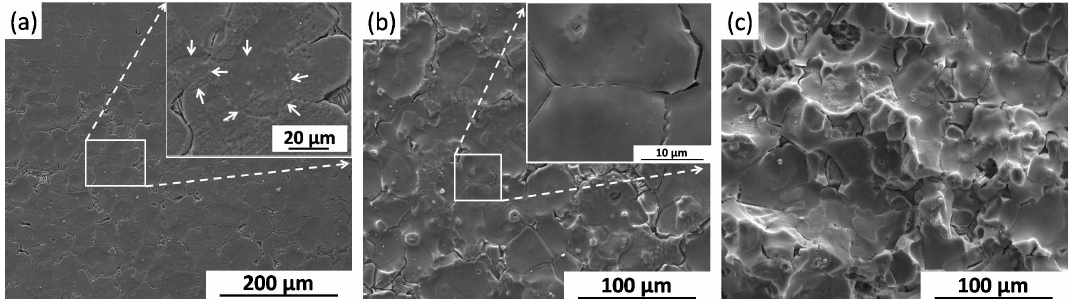
Figure 13. Surface morphologies of BM specimens after different immersion time intervals in SBF: ( a ) 0.5 h; ( b ) 1 h; and ( c ) 12 h (without corrosion products).